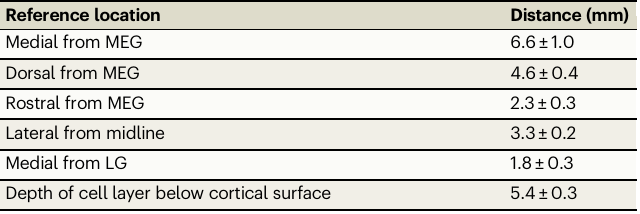
Table 1 | Measurements from 3D model of ferret brain for electrode implant target Reference